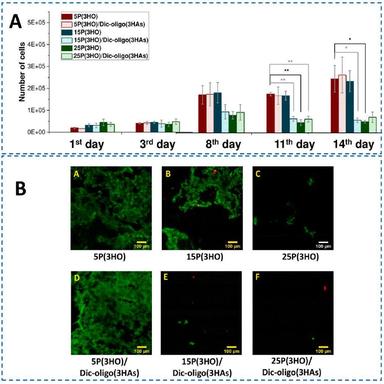
(A) The direct HaCaT proliferation test performed on the scaffold surface shows the increase in the number of cells over the experiment (n = 3, N = 3). The results are statistically significant when: p < 0.05, p < 0.01, and p < 0.001; (B) The analysis of direct HaCaT proliferation on biomaterial surfaces on day 14 of the conducted experiment, evaluated by Live/Dead staining assays.